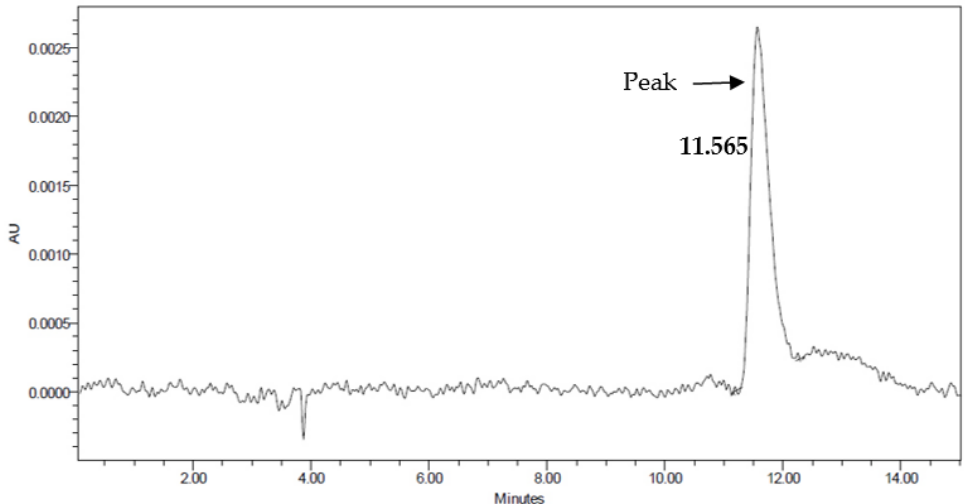
Figure 1. Chromatogram using an HPLC system with Kromasil ® packing material (C18, 100 Å pore size, 150 × 4.6 mm I.D., 5 µm particle size) for analysis of encapsulation efficiency of MIBI encapsulated in positive liposomes before 99m Tc labeling at a concentration of 0.76 ng/mL. Mobile phase, at 98:2%, including 0.1% trifluoroacetic acid in water/acetonitrile. The flow rate was 1 mL/min. A 260 nm UV detector was used. The x -axis represents the retention time, and the y -axis represents the absorbance units (AUs).